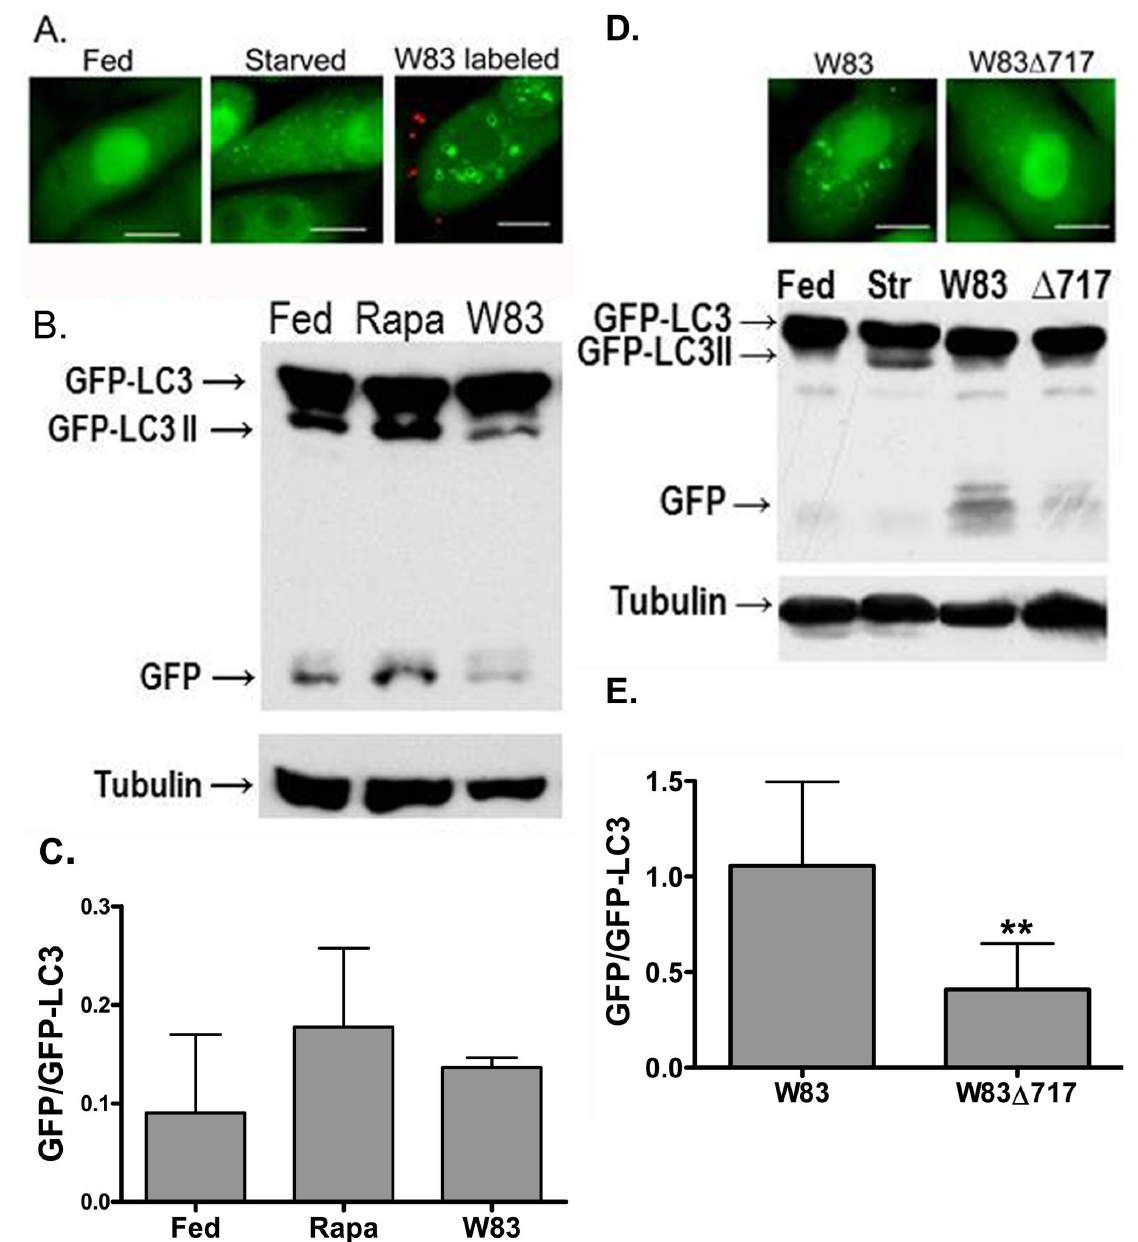
Figure 3. Induction of autophagy in Saos-2 cells. Saos-2 cells stably expressing GFP-LC3 were incubated in the presence and absence of P. gingivalis . After one hour, the cellular distribution of GFP-LC3 was visualized by fluorescence microscopy and its degradation assessed by Western blots. (A) Representative microscopic images of Saos-2 GFP-LC3 cells after one hour of starvation or co-culture with P. gingivalis . P. gingivalis were pre-labeled with Texas red before inoculation of Saos-2 cells. Scale bar is equivalent to 10 µm. (B) Saos-2 cell lysates were collected after 1 hour of fed conditions, rapamycin treatment (500 nM; “Rapa”), or incubation with W83. Tubulin was used as a loading control. A representative blot is shown. (C) Densitometric analysis of two Western blots including the blot shown in Figure 2B. (D) Representative microscopic images of Saos-2 cells after one hour of co- culture with W83 or W83Δ717 are shown in the upper segment; scale bar is equivalent to 10 µm. In the lower segment, Saos-2 cell lysates were collected after 1 hour of fed or nutrient-deprived (“Str”) conditions or after a one-hour incubation with W83 or W83Δ717 (“Δ717”). Tubulin was used as a loading control. (E) The degradative removal of GFP was significantly higher in cells exposed to W83 than in those incubated with W83Δ717. Values represent the mean ± SD of 4 independent experiments. **Ratios were significantly different as determined by unpaired Student’s t -test ( P < 0.04). doi: 10.1371/journal.pone.0074230.g003 PLOS ONE |